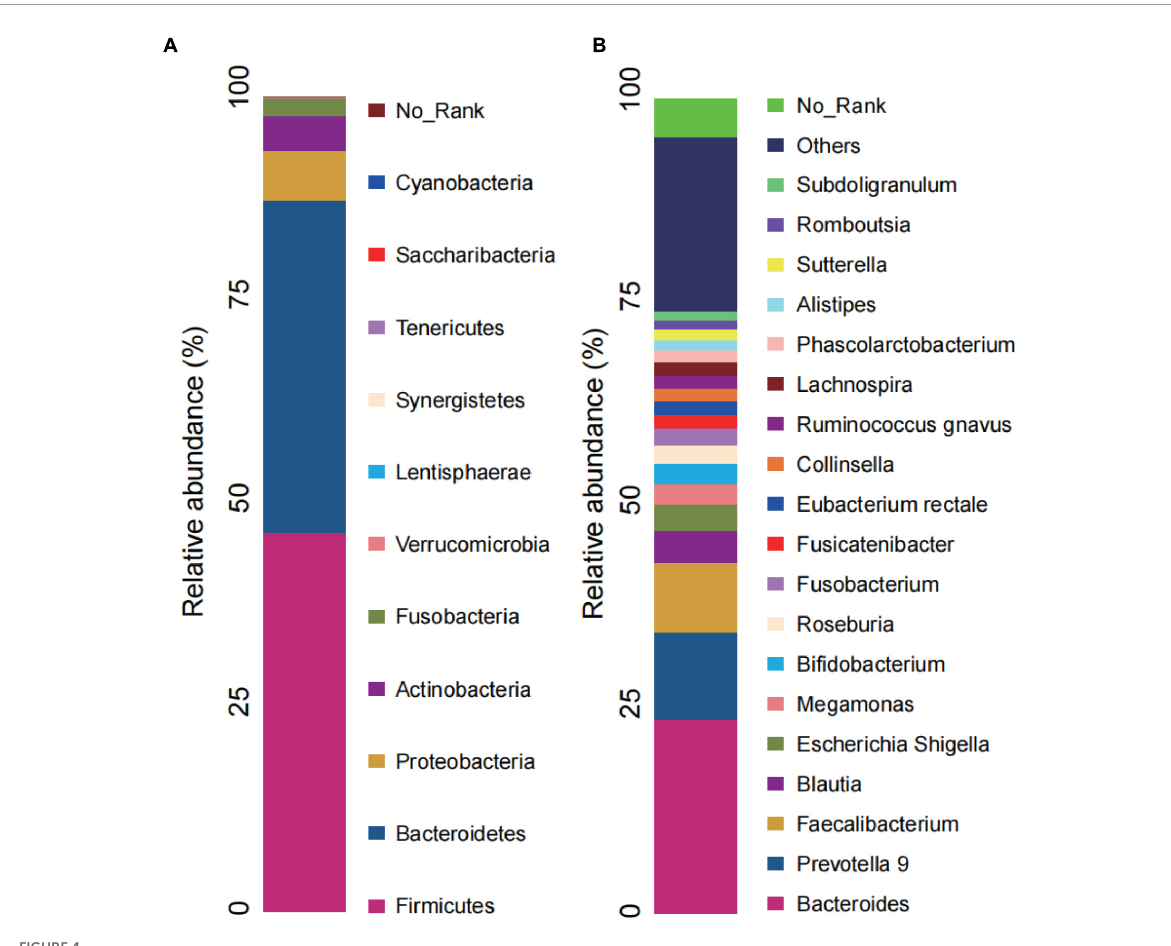
FIGURE4 Microbial composition in CI. (A) Relative abundance bar charts of GM in the CI group at the phylum level. (B) Relative abundance bar charts of GM in the CI group at the genus level. GM, gut microbiota; CI, chronic